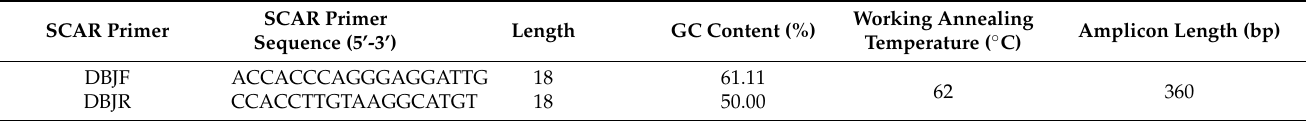
Figure 2. Nucleotide sequence of the SCoT marker specific to C. morifolium ‘Daboju’. The sequence was named SCoT36-360 and has been deposited in GenBank (Accession number: OL456174). The underlined bold sequences represent the forward primer (DBJF) and the reverse primer (DBJR). Table 2. Characteristics of the cultivar-specific SCAR primer pair derived from the cloned SCoT36- derived amplicon of C. morifolium